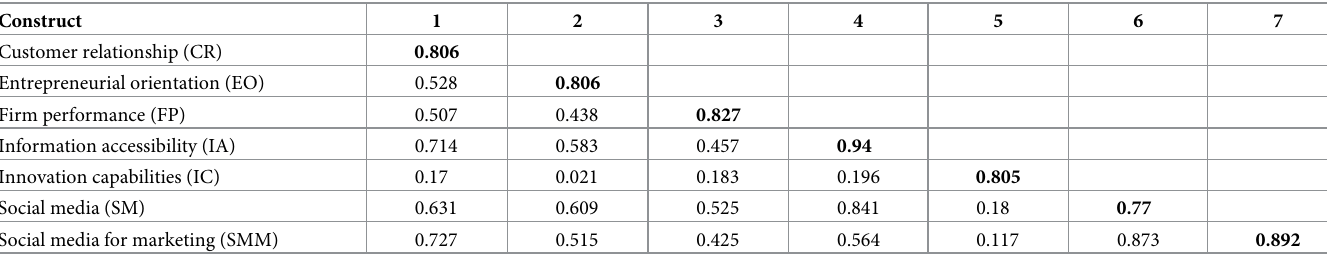
Table 3. Latent variable correlation and square root of